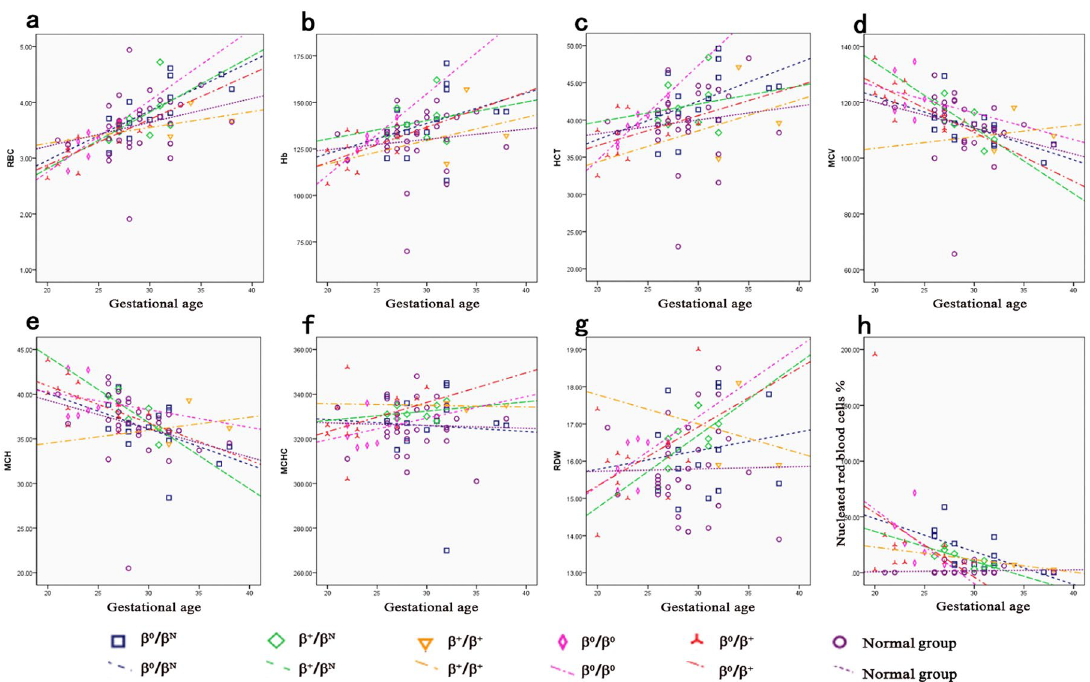
Figure 4. Distribution of red blood cell indices in five β-thalassemia genotypes at different gestational ages. The trends of RBC ( a ), Hb ( b ), HCT ( c ), MCV ( d ), MCH ( e ), MCHC ( f ), RDW ( g ) and nucleated erythrocytes ( h ) with increased gestational ages in five β-thalassemia genotypes carriers and normal group were